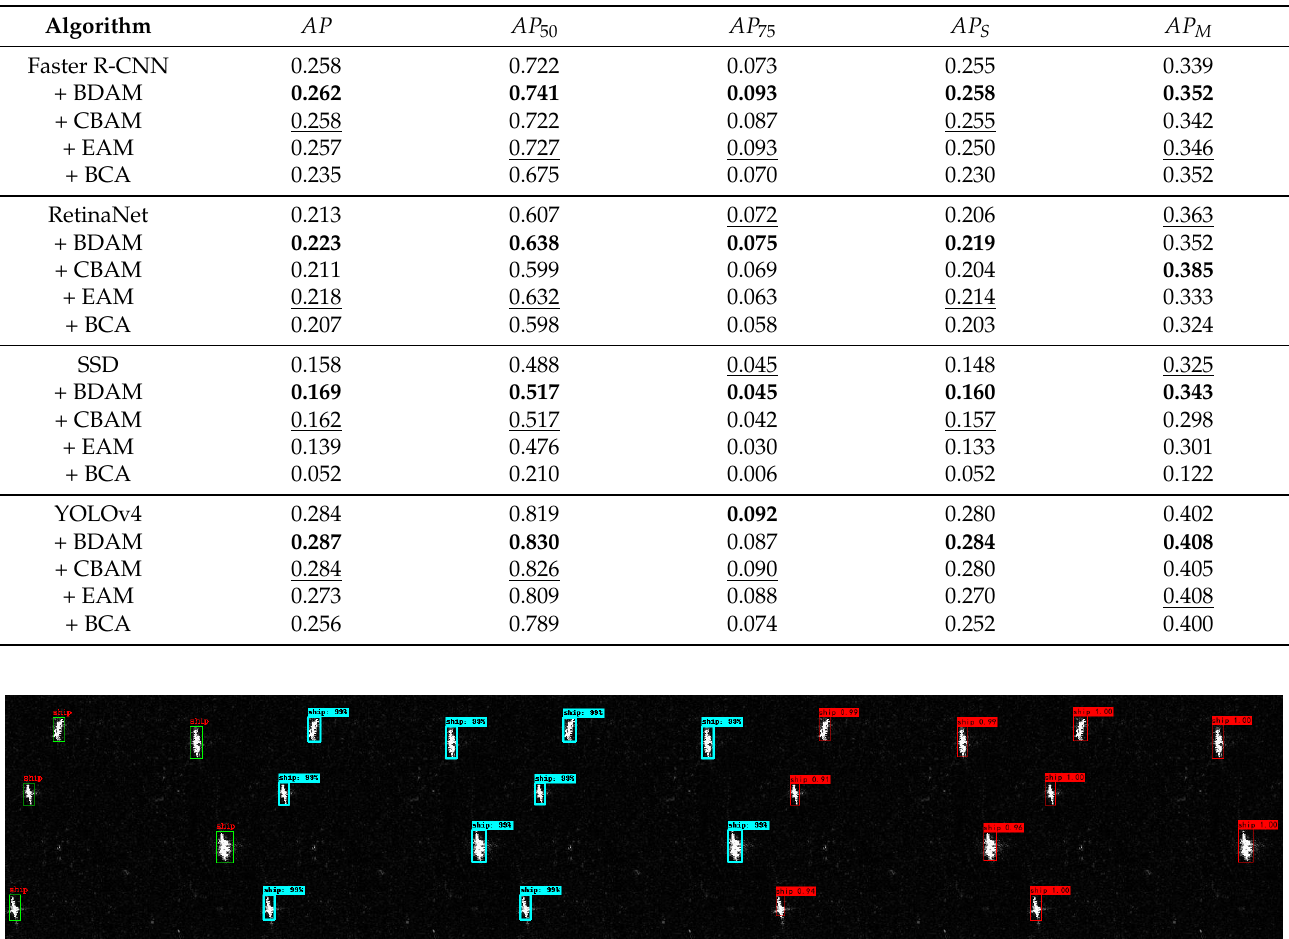
Table 8. Experimental results of different algorithms on dataset LS-SSDD. LS-SSDD does not contain large ships, so the metrics of AP L do not apply to it. Bolded data represent the best and underlined data represent the second best.